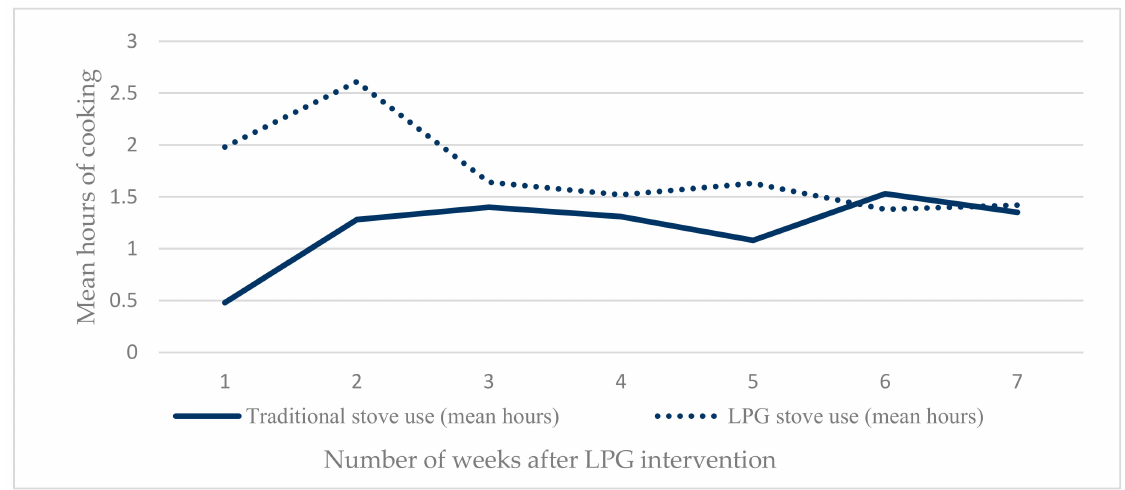
Figure 2. Mean hours of cooking in previous 24 h per visit by stove